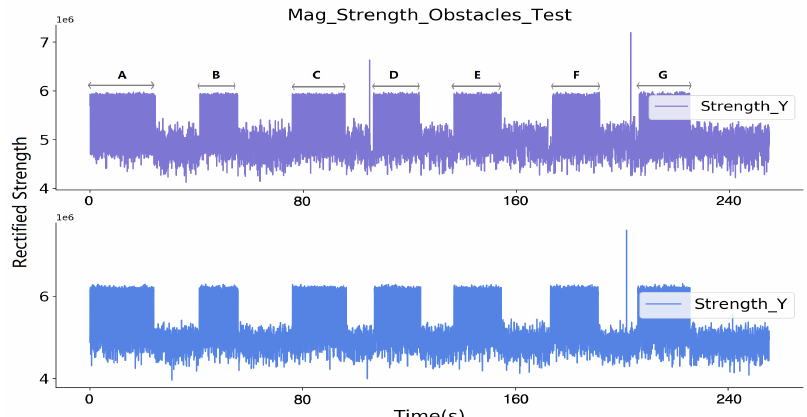
Figure 14. Received strength signals from two prototypes after removing prototype’s own magnetic field, where nothing in between in time window A and different obstacles in the other six time